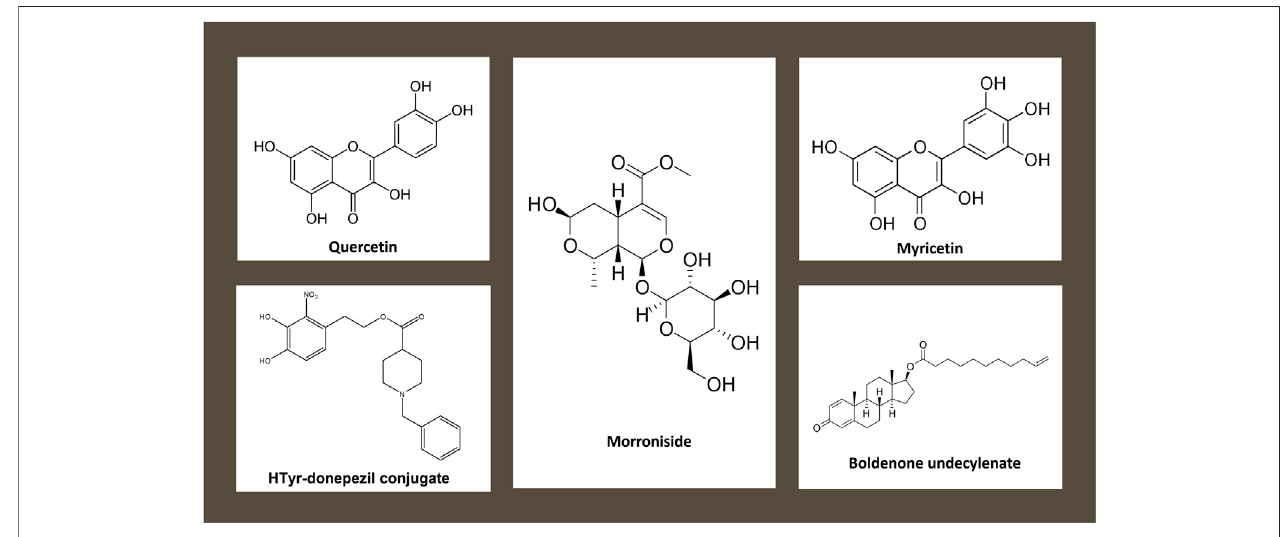
FIGURE 1 | Chemical structures of natural and nature inspired antioxidant molecules investigated by this research